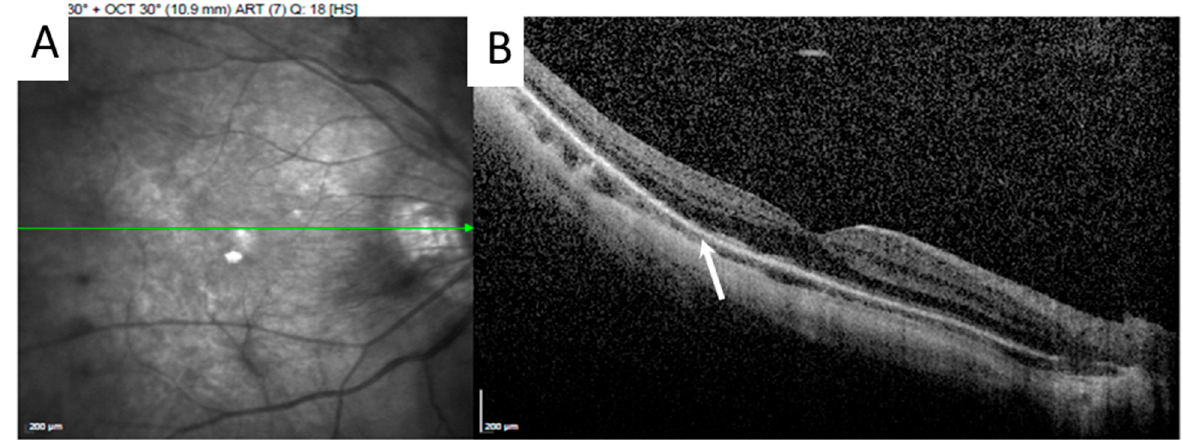
Figure 4. The green line over the infrared red image ( A ) represents the OCT scan position . High- resolution OCT showed focal disruption of both the ellipsoid and RPE–photoreceptor interdigitation zones ( B , arrow) over the right eye.